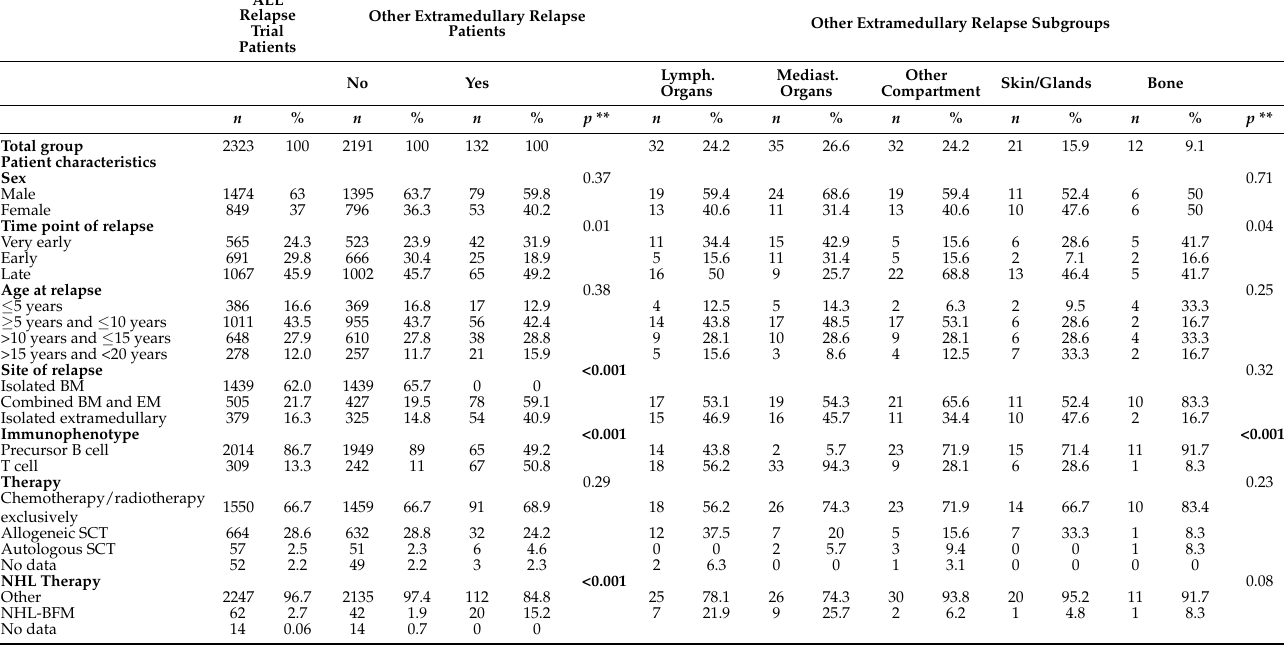
Legend to Table 2: ** Pearson/chi-squared or Fisher’s exact test, missing values excluded. Abbreviations: BCP, B-cell precursor; BM, bone marrow; EM, extramedullary; NHL-BFM, Non-Hodgkin’s Lymphoma Berlin–Frankfurt–Munster protocol; SCT, stem cell transplantation; SE, standard